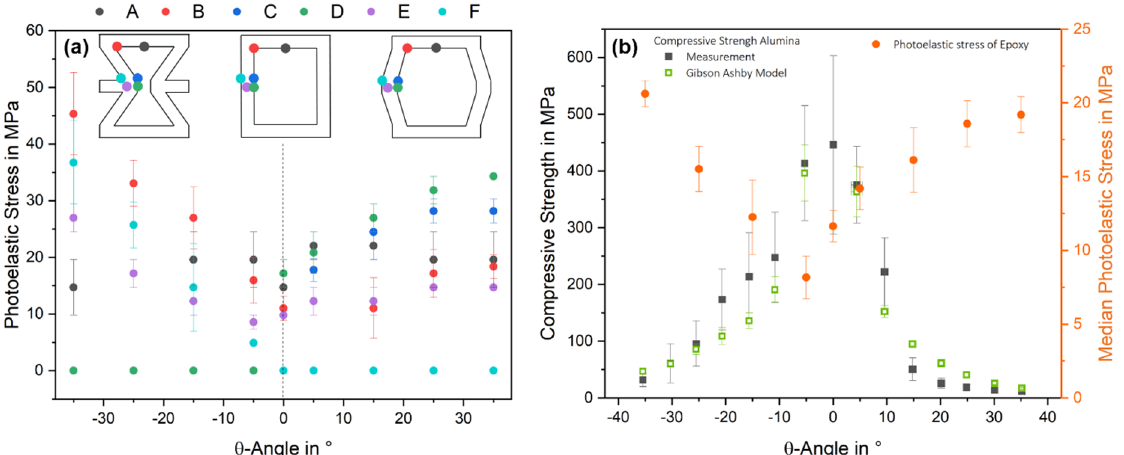
Figure 4. ( a ) Photoelastic stress at defined measurement points for the epoxy resin unit cells depending on the θ -angle ( θ ≥ 0 hexagonal, θ < 0° auxetic). ( b ) Compressive strength of alumina ceramic unit cells dependent on the θ -angle and the median photoelastic stresses in the epoxy resin unit cells.